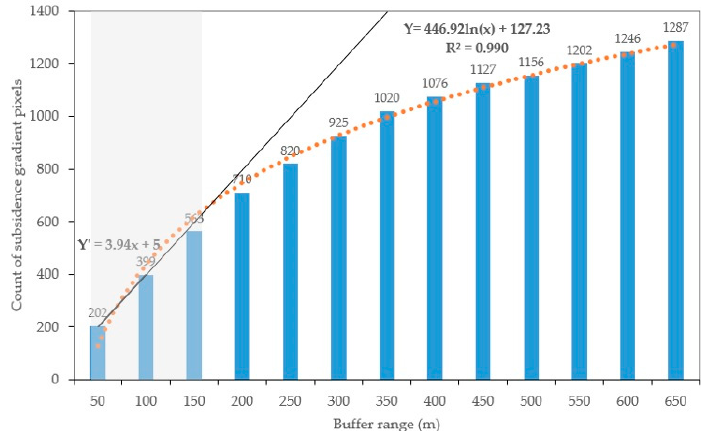
Figure 8. Statistical results of the subsidence gradient in the coal mining area from 2006 to 2011. The blue columns of the histogram refer to the count of subsidence gradient pixels in the di ff erent bu ff er